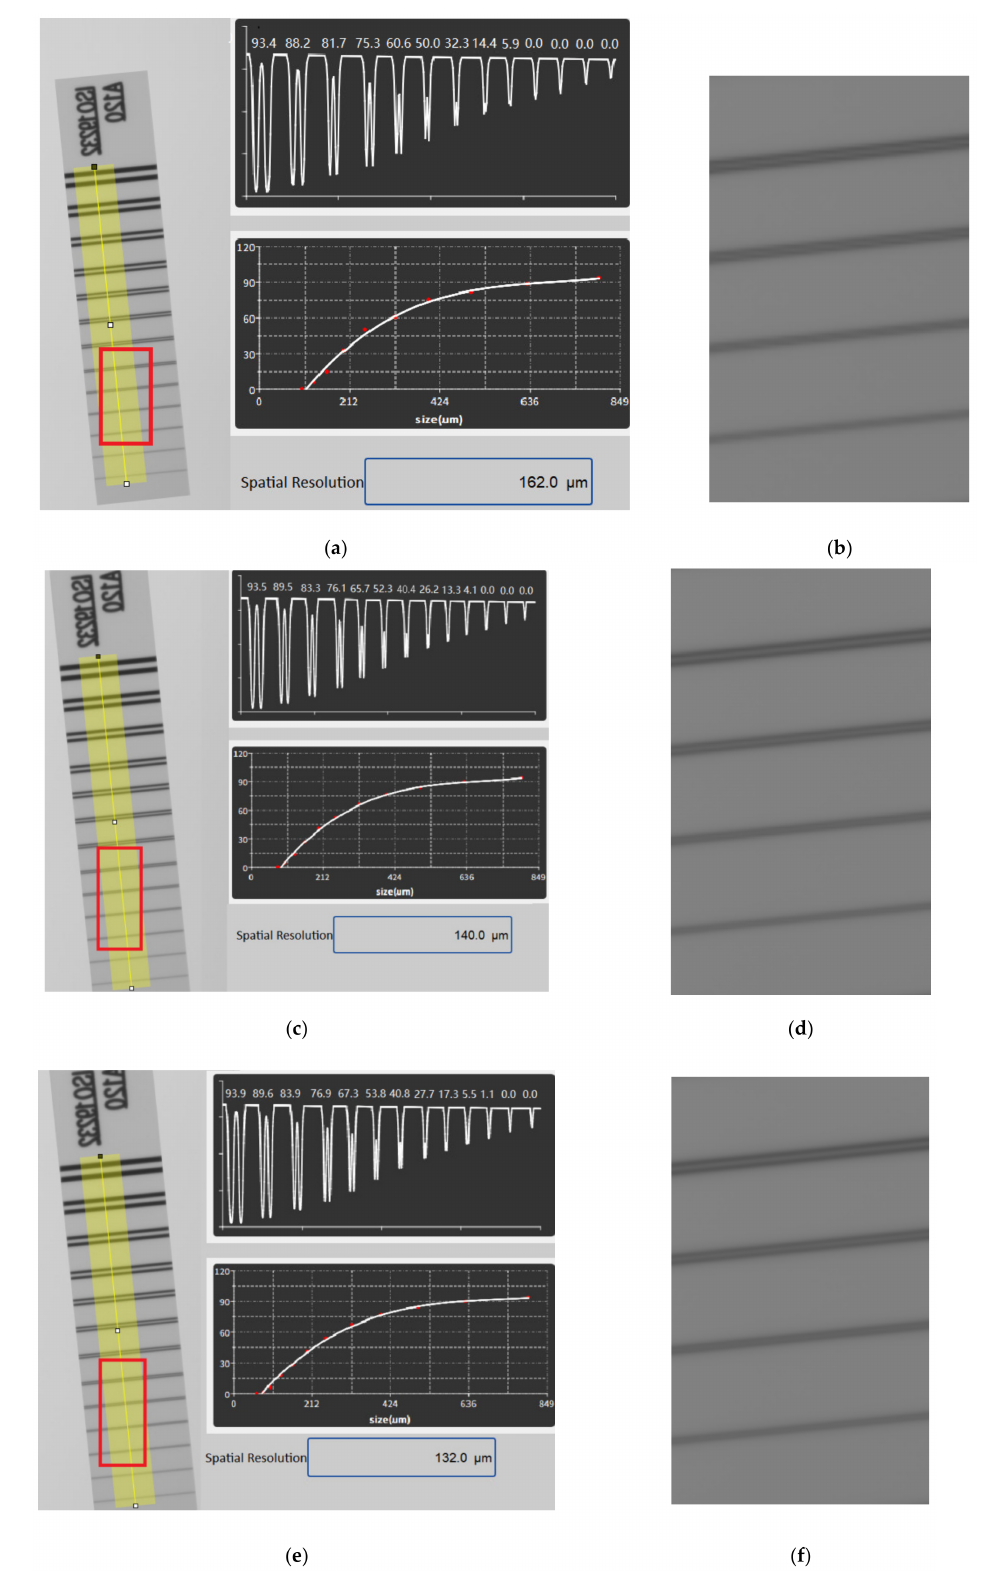
Figure 9. The basic spatial detector resolution SR detector image, ( e ) 4 × 4 sub-pixel shift image; ( b , d , f ) are the corresponding local enlargement of the boxed areas of the duplex wire